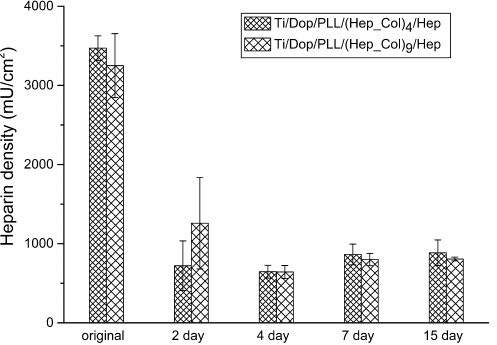
Figure 11. Heparin density of two samples, Ti/Dop/(Hep_Col) 4 /Hep and Ti/Dop/(Hep_Col) 9 /Hep, from the beginning to the end of various periods of the tests conducted by the orbital shaker ( N = 3).